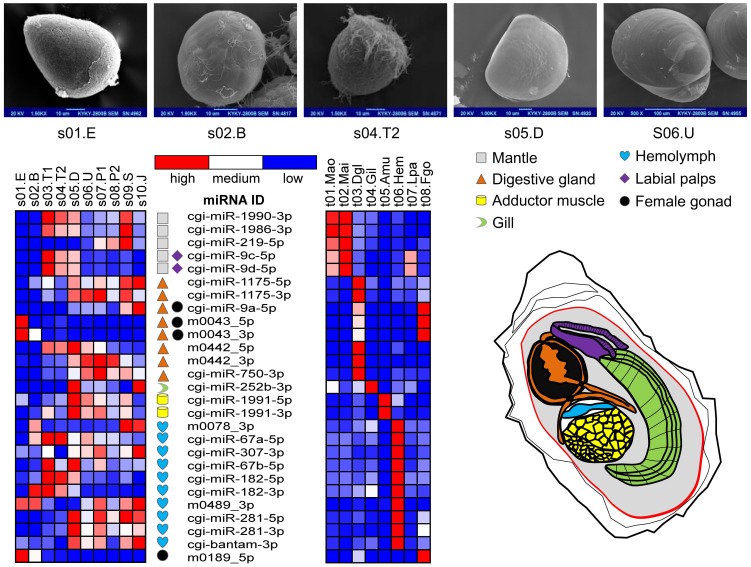
Organ-specific expressed miRNAs and their expression patterns during different development stages and in different organs.The abbreviations of organs and developmental samples in each heat map are as detailed in the legend to Figure 1. A color bar is provided where blue indicates a low expression level, red indicates a high expression level, and the white indicates medium expression levels. The electron microscope (EM) photos show part of the development stages and there is also a sketch of the main adult organs. The EM photos for s04.T2, s05.D, and s06.U were from Zhang et. al.
[17]. The organs are indicated with different colors according to the scheme shown in the sketch while they are also indicated in front of the miRNA IDs.